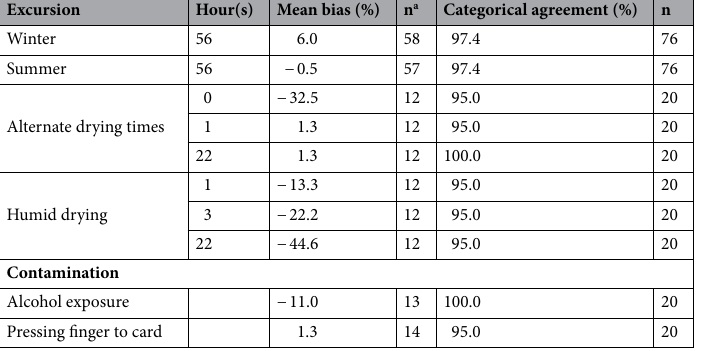
Table 4. Summary of DBS robustness study results. a Results below LOD were excluded from bias analysis.